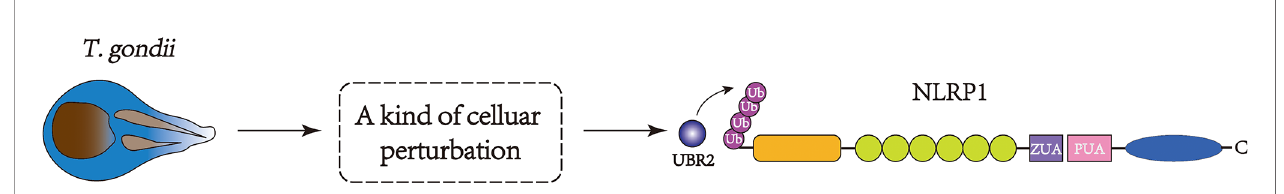
FIGURE 4 | The pathogen-associated effects induced by T. gondii infection, DPP8/9 inhibitors, or metabolic inhibitors can be detected by the indirect activation of the NLRP1 in fl ammasome. These activities can initiate perturbations in cells, which may stimulate the E3 ligase, resulting in the ubiquitination and degradation of the N-terminus of